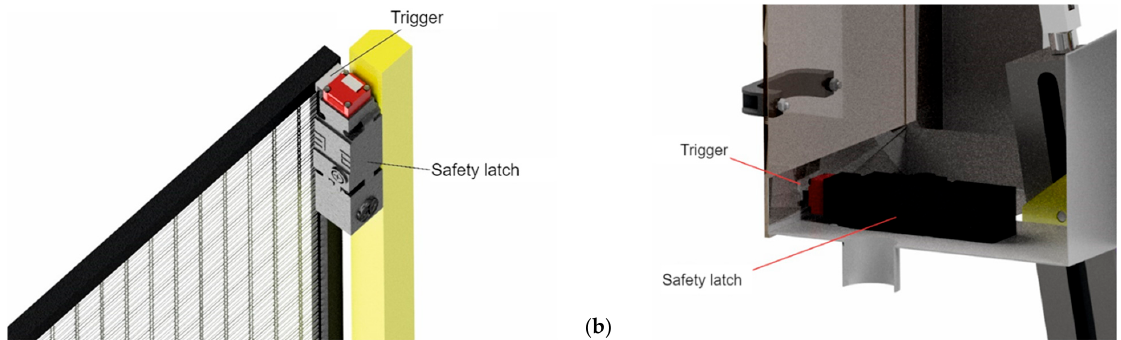
Figure 23. Safety latch for the machine access doors ( a ) and cutting disk housing’s safety latch ( b ). The cutting disk housing has the function of protecting the user during operation.